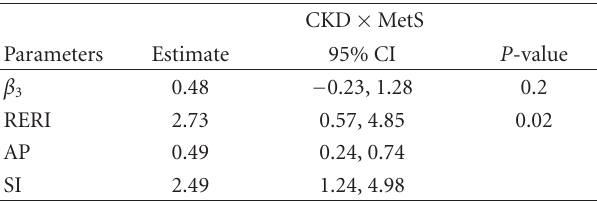
Table 3: Estimates of multiplicative and additive interaction (95% confidence interval, CI) controlling for